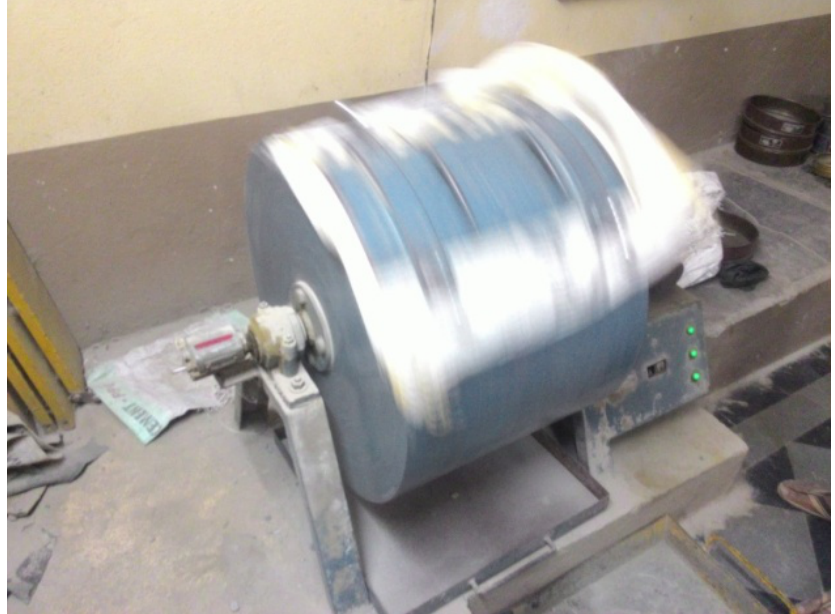
Fig. 3. Los Angles abrasion machine